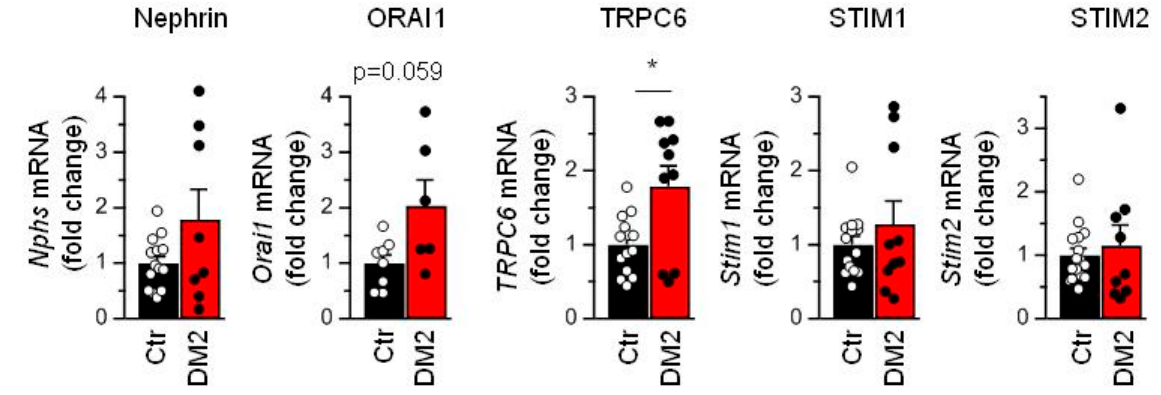
Figure 5. Diabetes leads to the increase in TRPC6 mRNA expression level. Shown are averaged data and individual data points for expression of Nephrin, Orai1, TRPC6, STIM1 and STIM2 mRNA. Data were analyzed by two-tail Mann–Whitney test. * indicate p values of